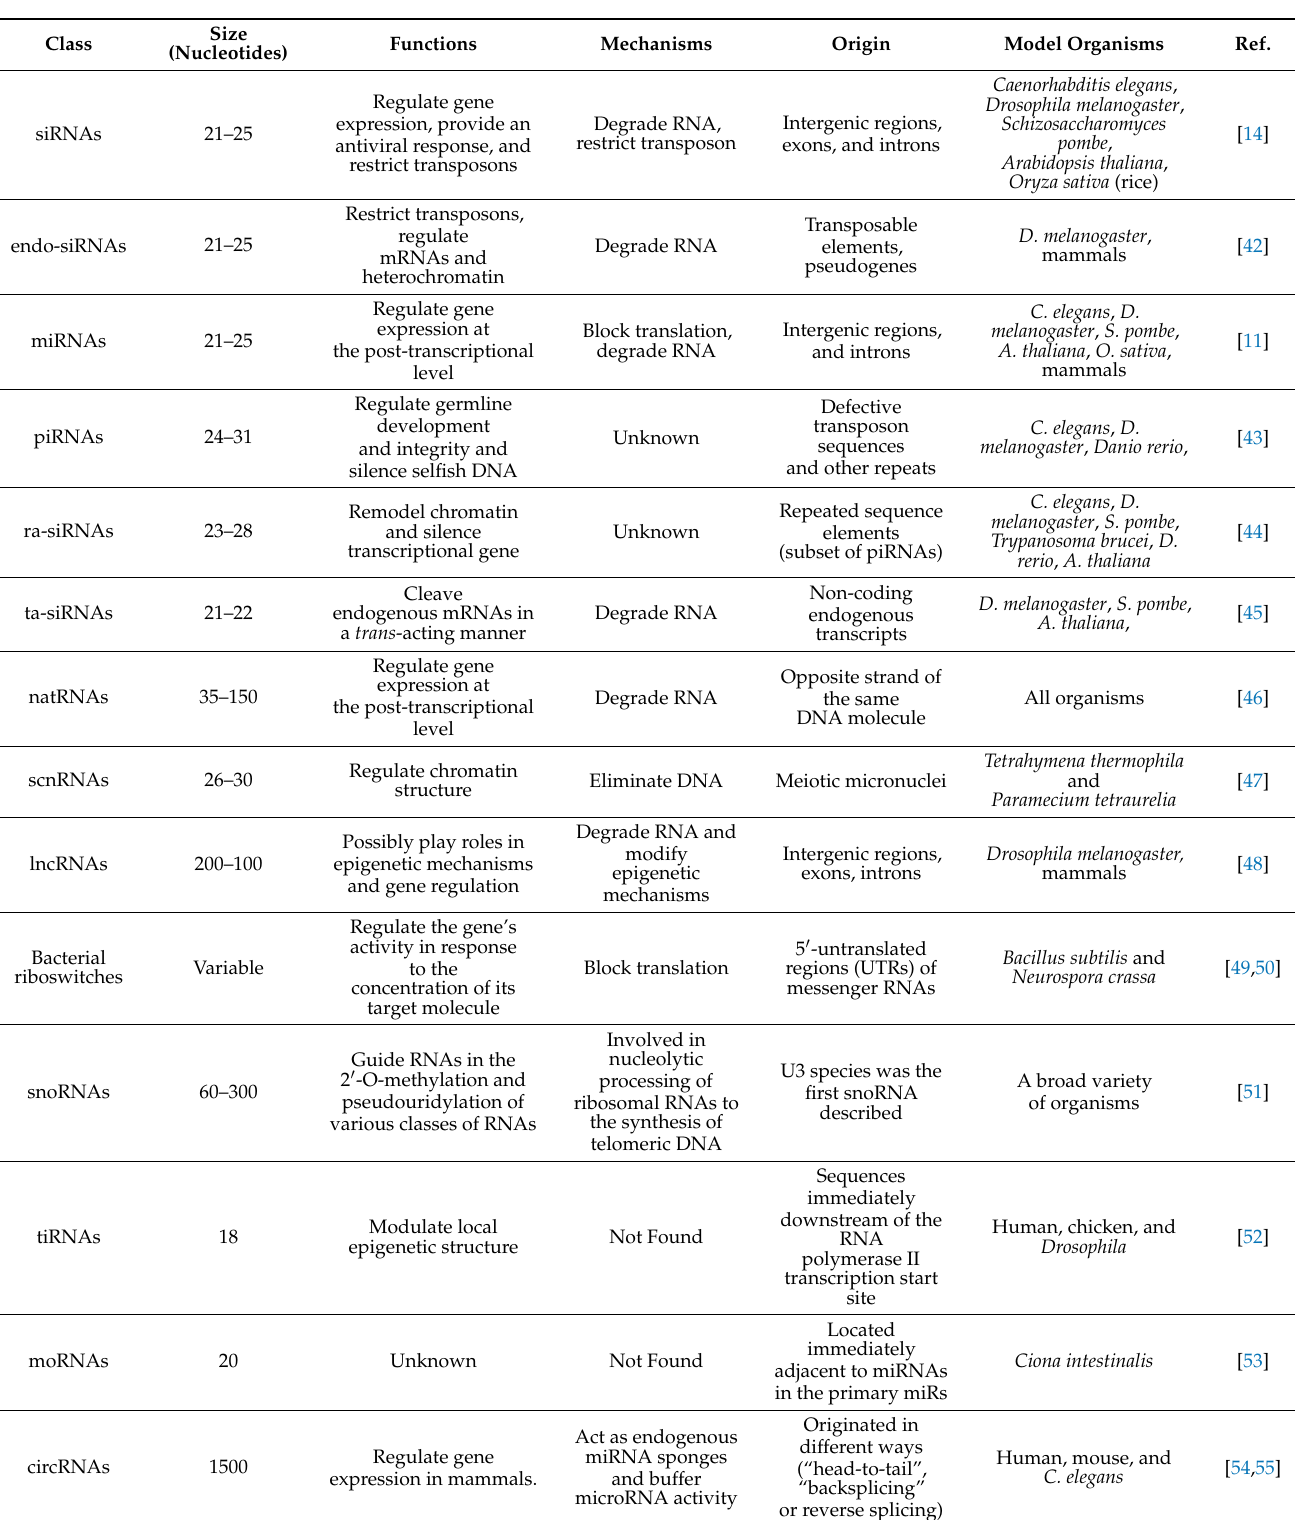
Table 1. Cellular non-coding RNAs involved in gene